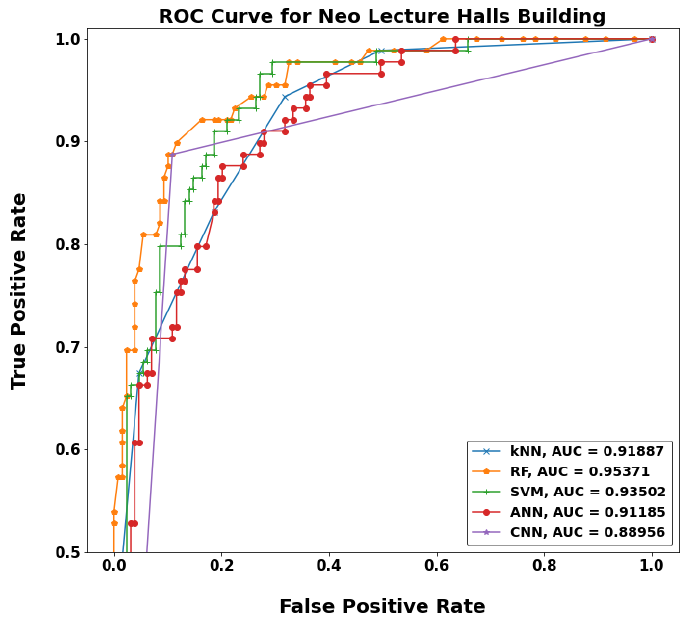
Figure 23. ROC curves for MF-ML models in Neo LH building.